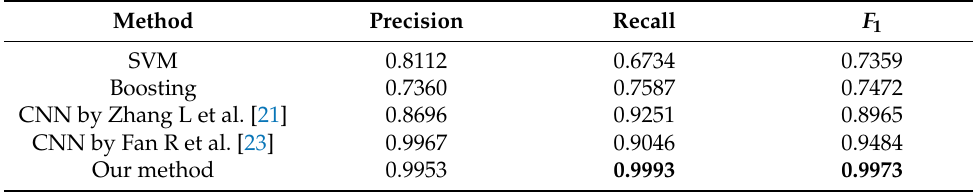
Table 1. Classification